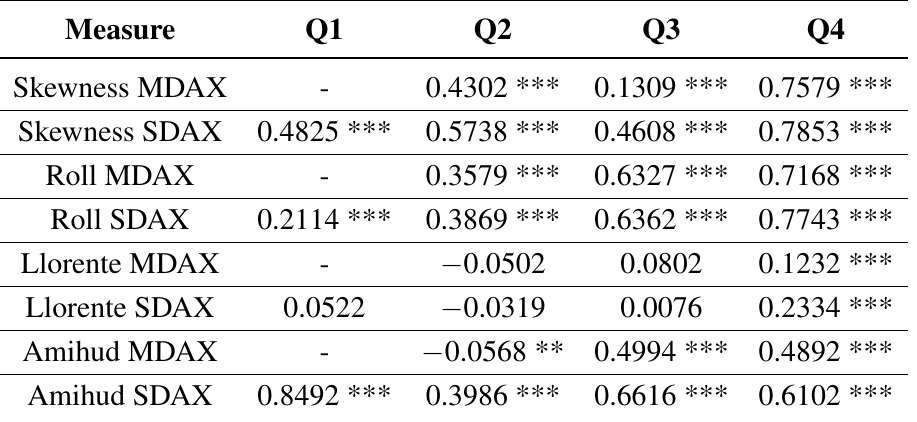
Table 8. Quartile correlations of real estate, MDAX and